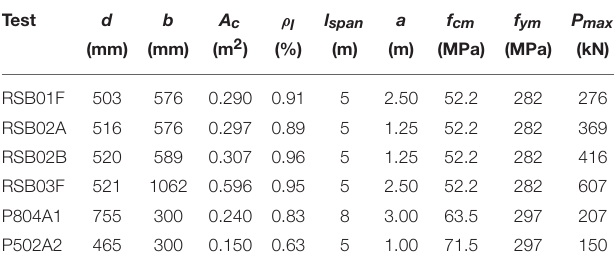
TABLE 5 | Overview of properties of beams tested in the laboratory failing in flexure.